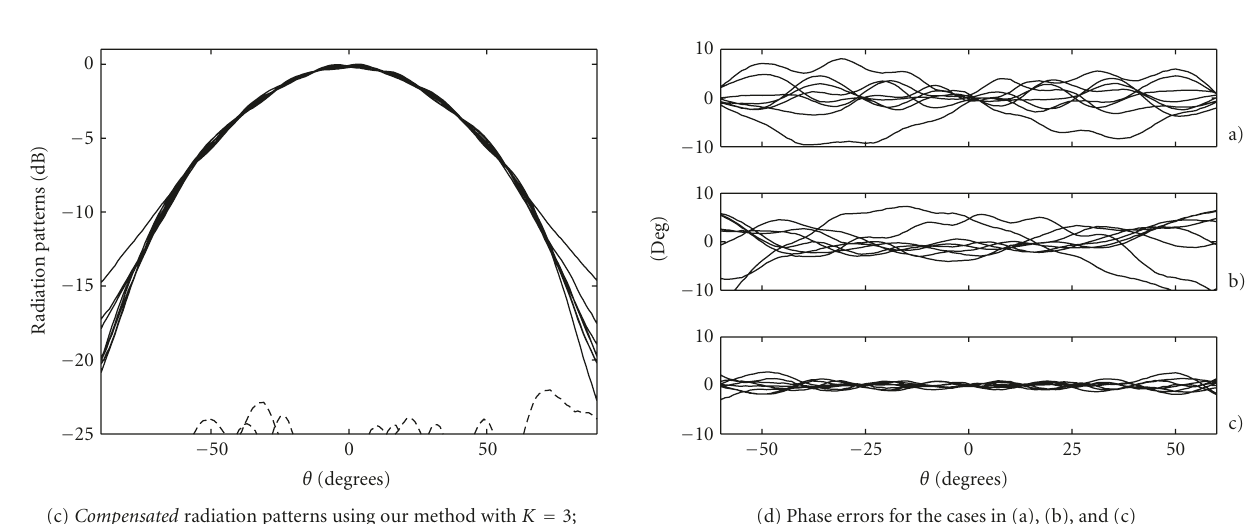
Figure 8: Radiation patterns obtained from compensated data with the coupling matrix C estimated in di ff erent ways. The measurements are from the 8-element dual polarized array in Figure 7 with co- (solid) and cross- (dashed) polarization collected during calibration.